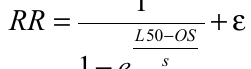
Fig. 5. Regression models that give high degrees of explana - tion, with recovery rate as dependent and otolith width as